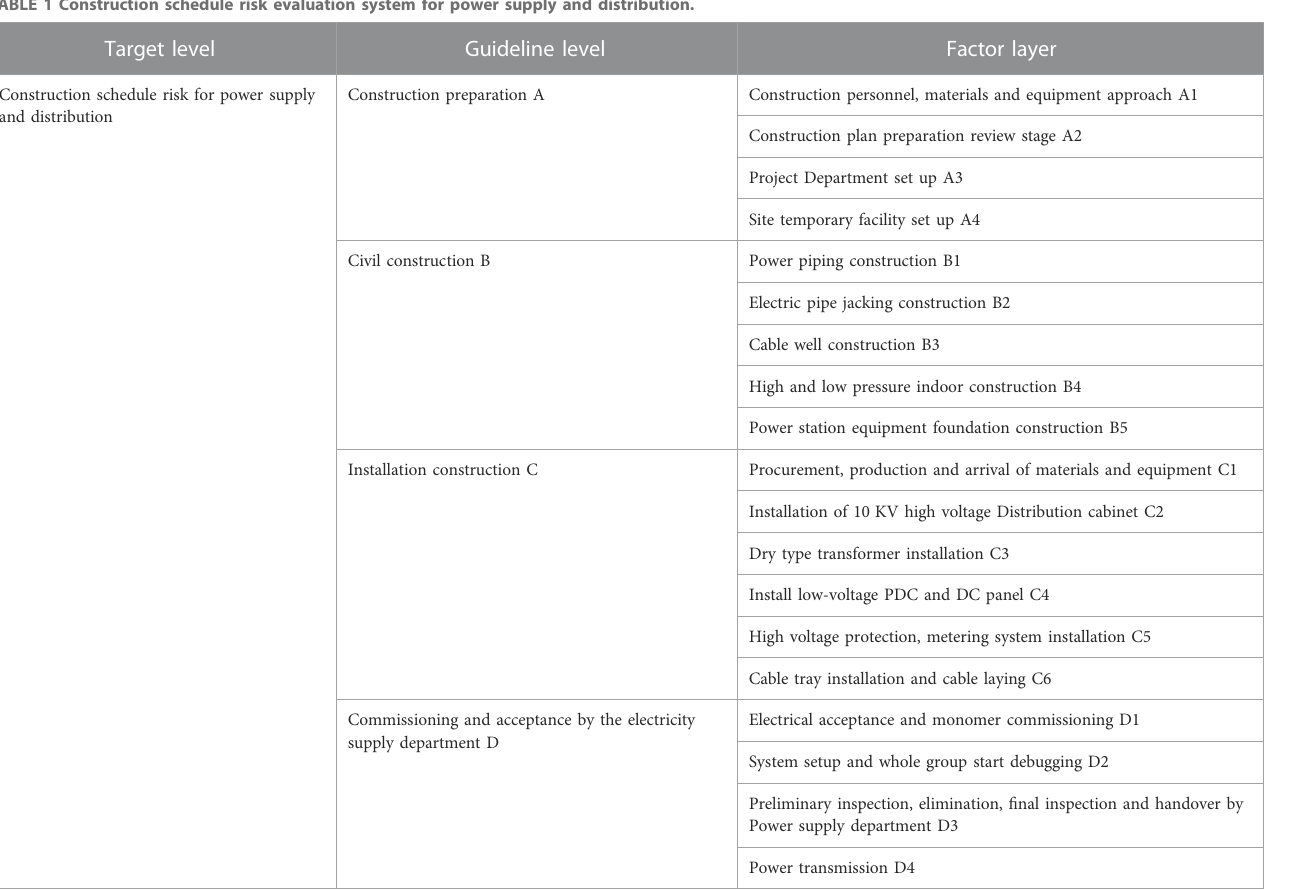
TABLE 1 Construction schedule risk evaluation system for power supply and